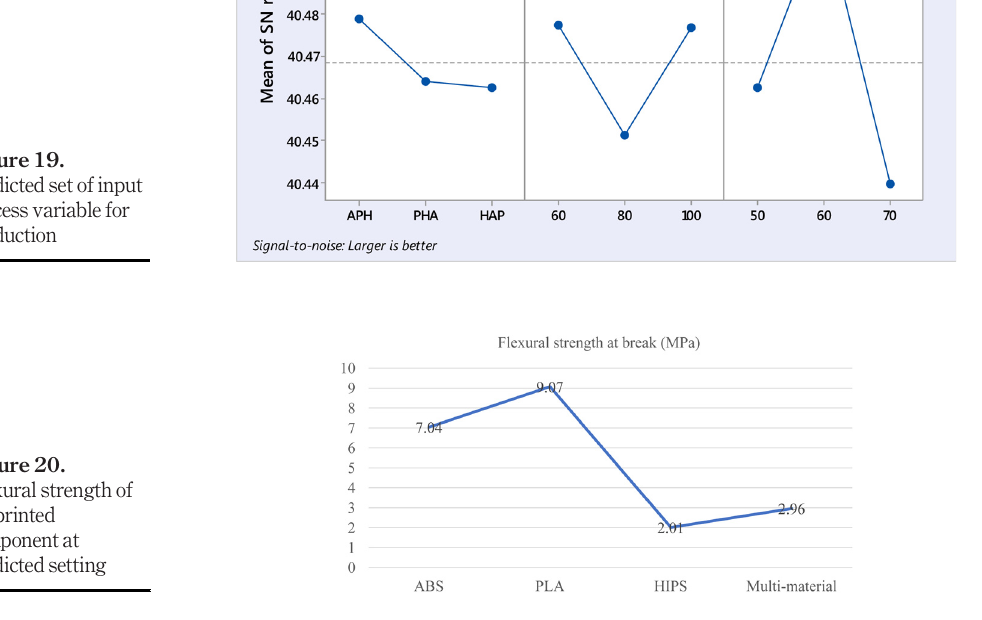
Figure 20. Flexural strength of 3D printed component at predicted setting